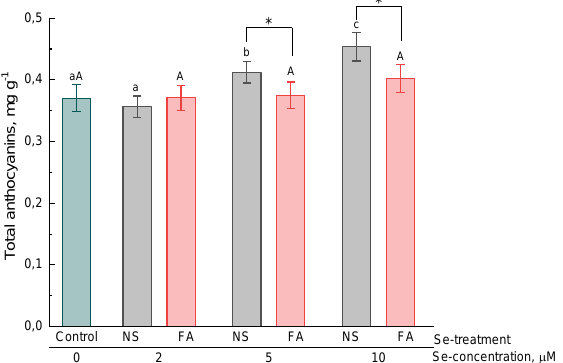
Figure 3. Effect of type and concentration of Se application on the total anthocyanin content in basil leaves.